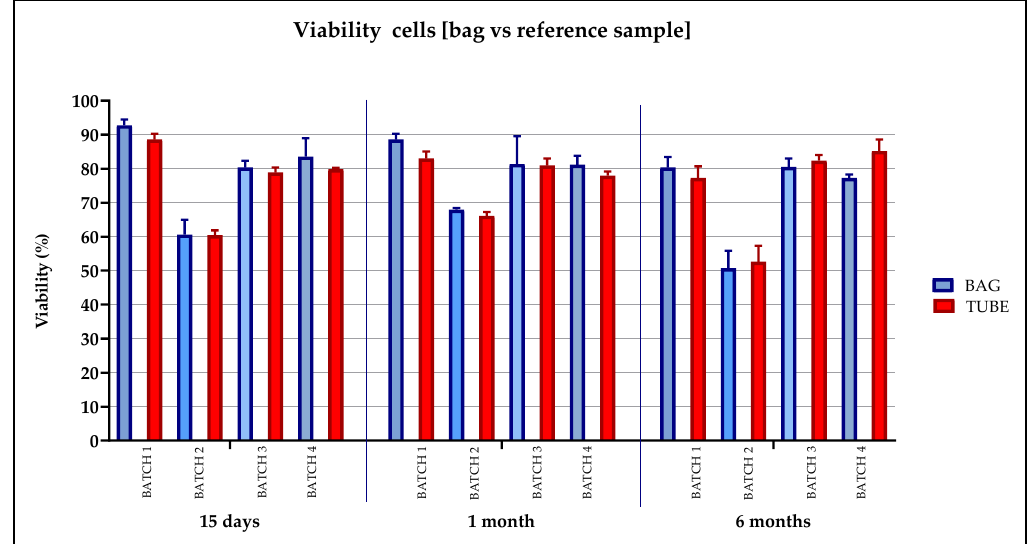
Figure 7. Viability evaluated on Batches 1, 2, 3 and 4 to validate the stability of the cellular product in bags and tubes. The percentage of viable cells was calculated concurrently on the bags (red histograms) and tubes (blue histograms) at the different cryopreservation time periods: 15 days, 1 month and 6 months.